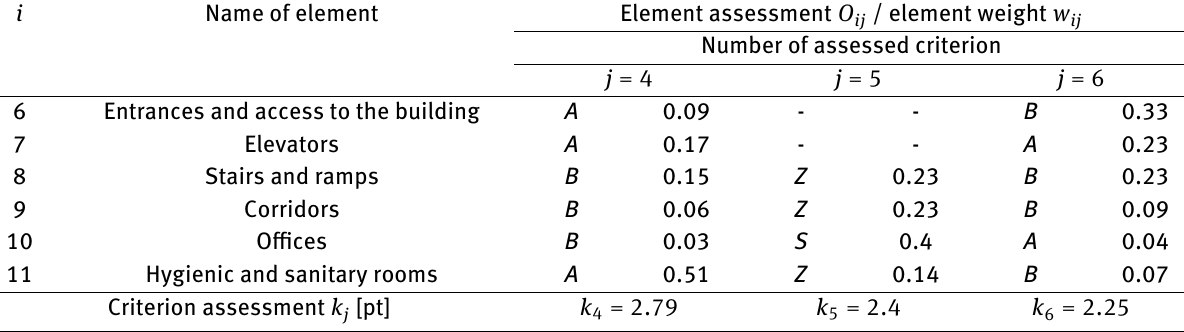
Table 3: Evaluation of the building according to the criteria k 4 , k 5 , k 6